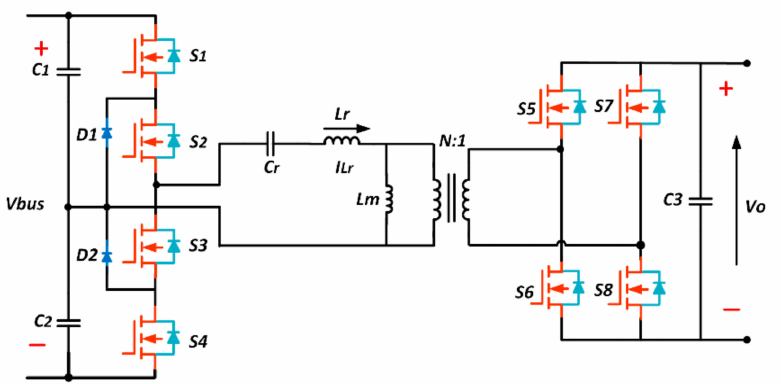
Figure 37. Circuit diagram of three-level natural diode-clamped bidirectional LLC resonant con- verter